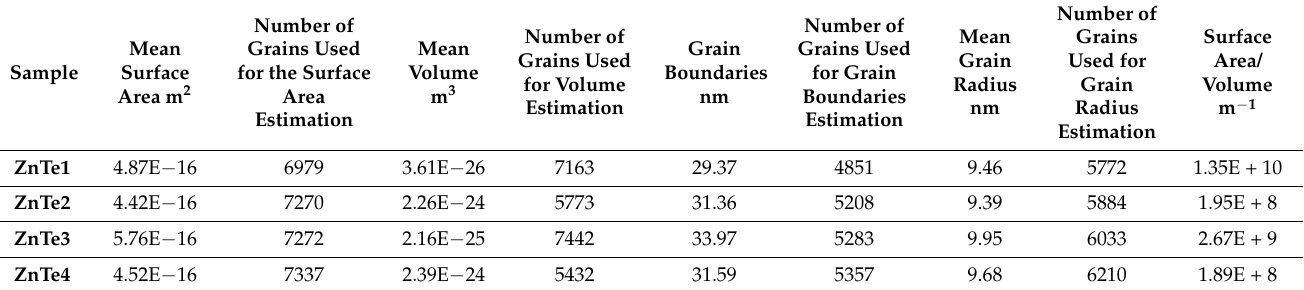
Table 1. The size and specific parameters for the grains.